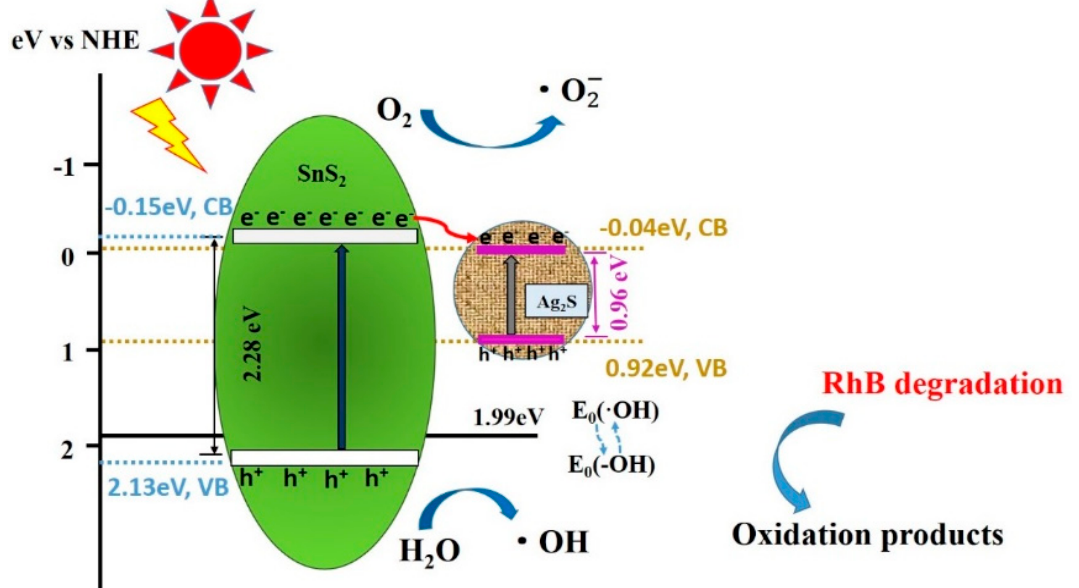
Figure 10. The schematic diagram of photocatalytic mechanism of Ag 2 S@SnS 2 composites under simulated sunlight.